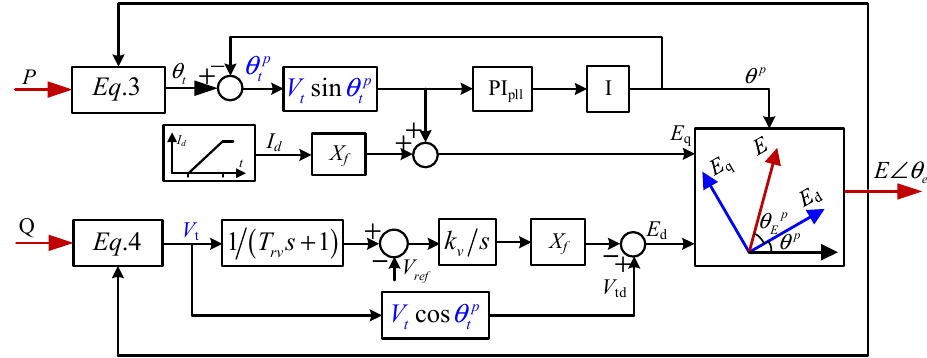
Figure 4. Motion equation mode in stage of active power climbing.